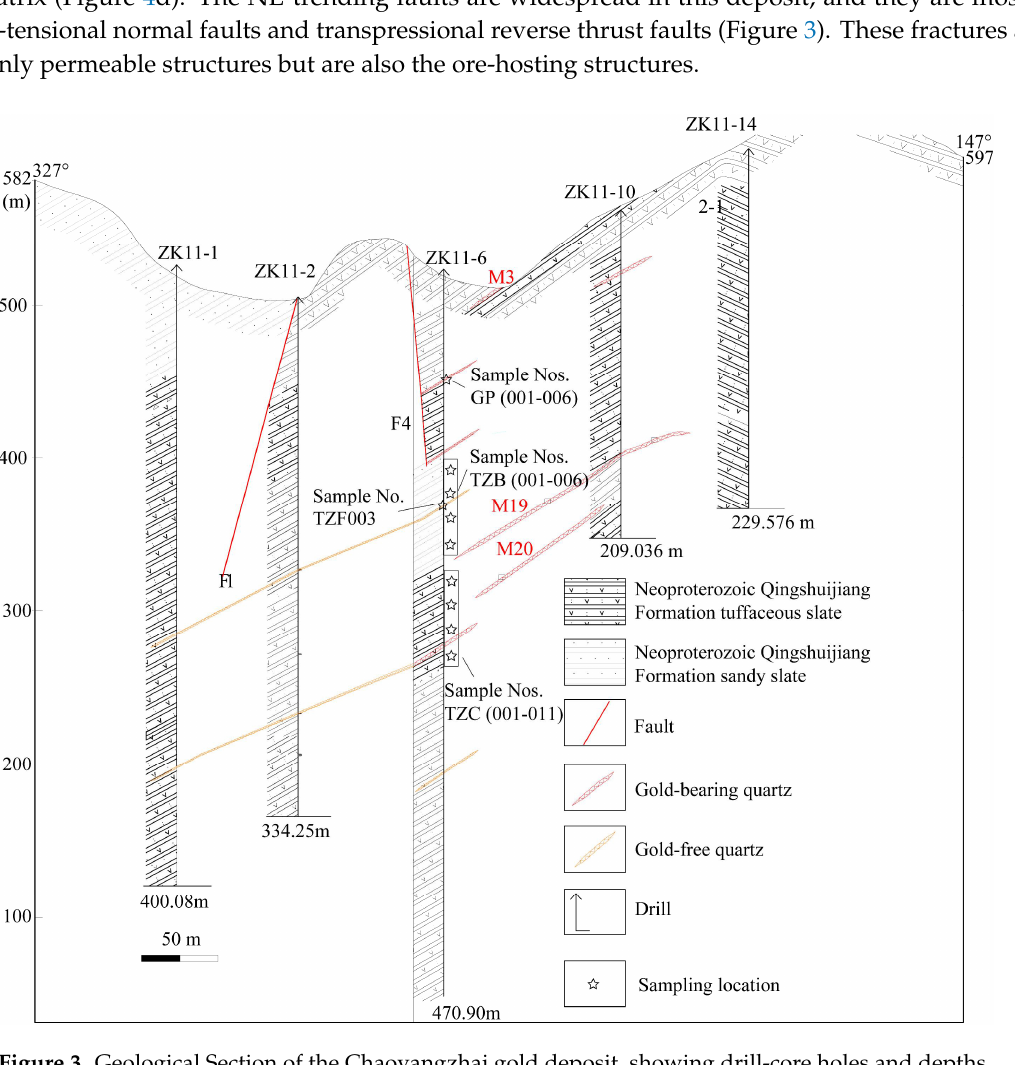
Figure 3 Figure 3. Geological Section of the Chaoyangzhai gold deposit, showing drill-core holes and